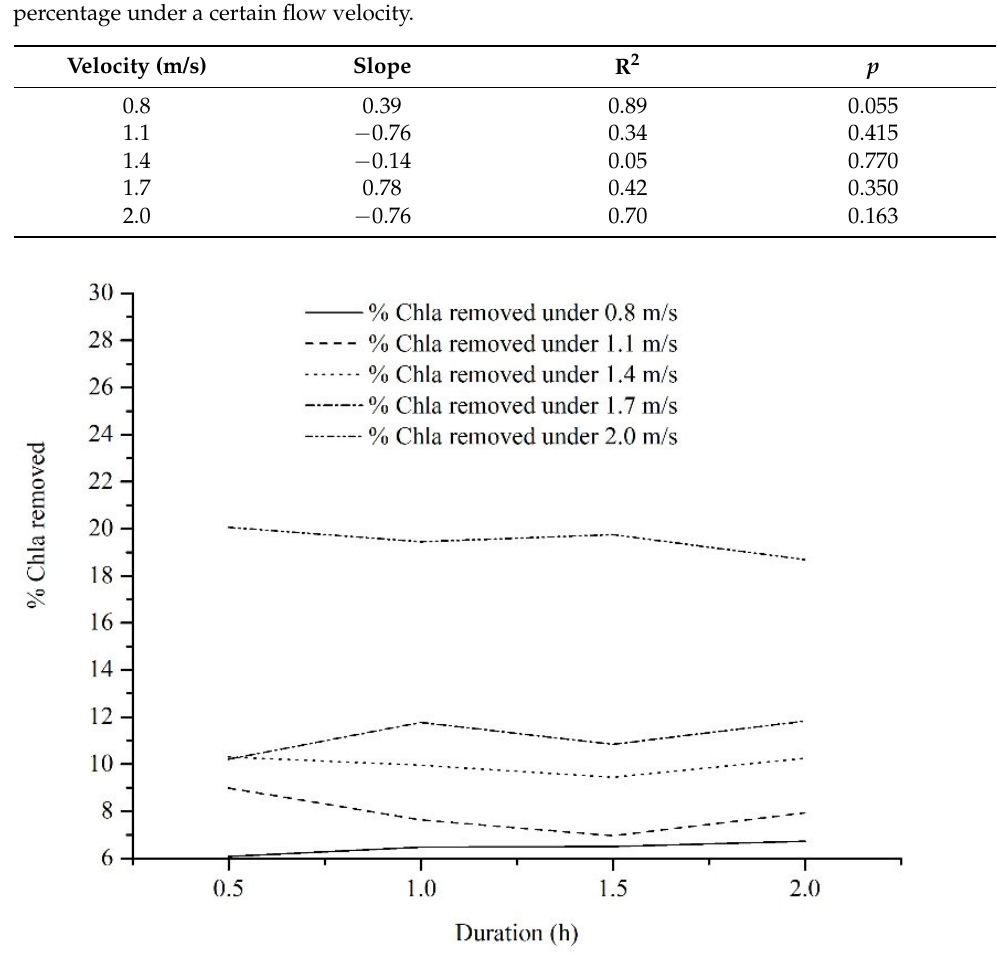
Table 1. Summary of linear regression results for the effect of scouring duration on biomass removal percentage under a certain flow velocity.